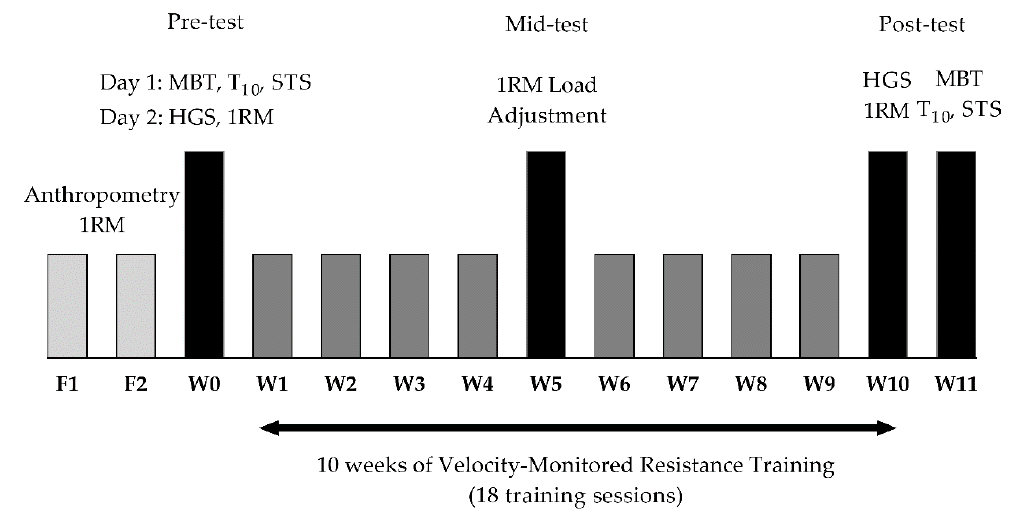
Figure 1. Study design; Abbreviations: 1RM: one-repetition maximum; F1: week 1 of